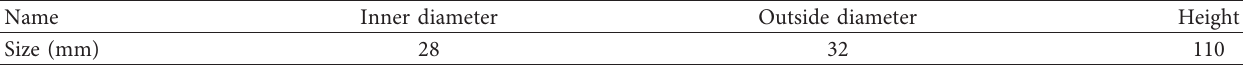
Figure 1: Geometric parameters. (a) Geometric section view. (b) Computational domain. Table 1: Geometric dimensions of thermowell.